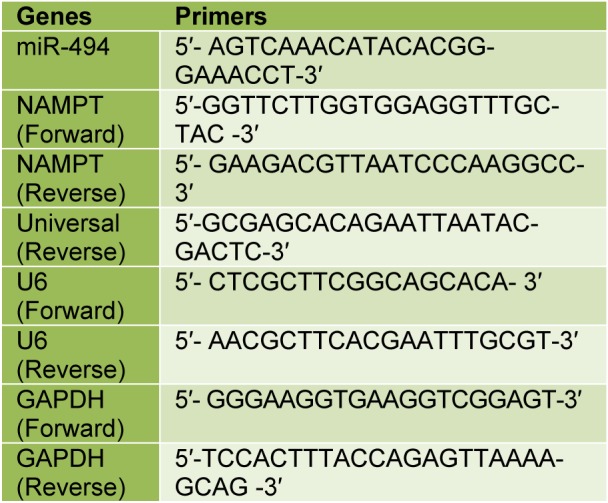
Sequence of primers